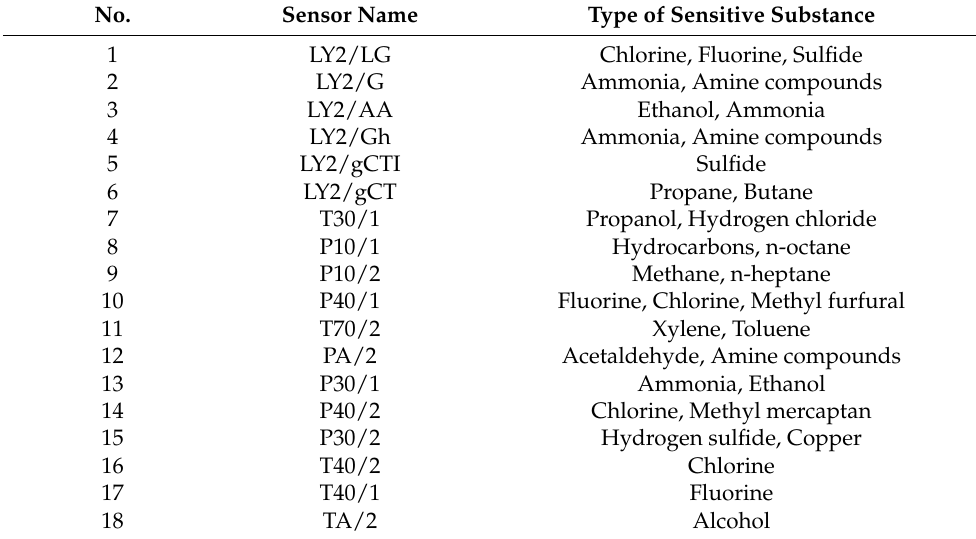
Table 1. Performance characteristics of electronic nose